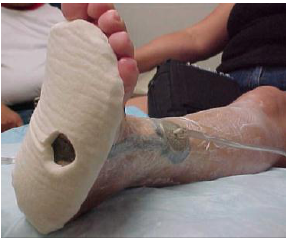
Figure 4. Application of 1/4 inch felt at week seven.